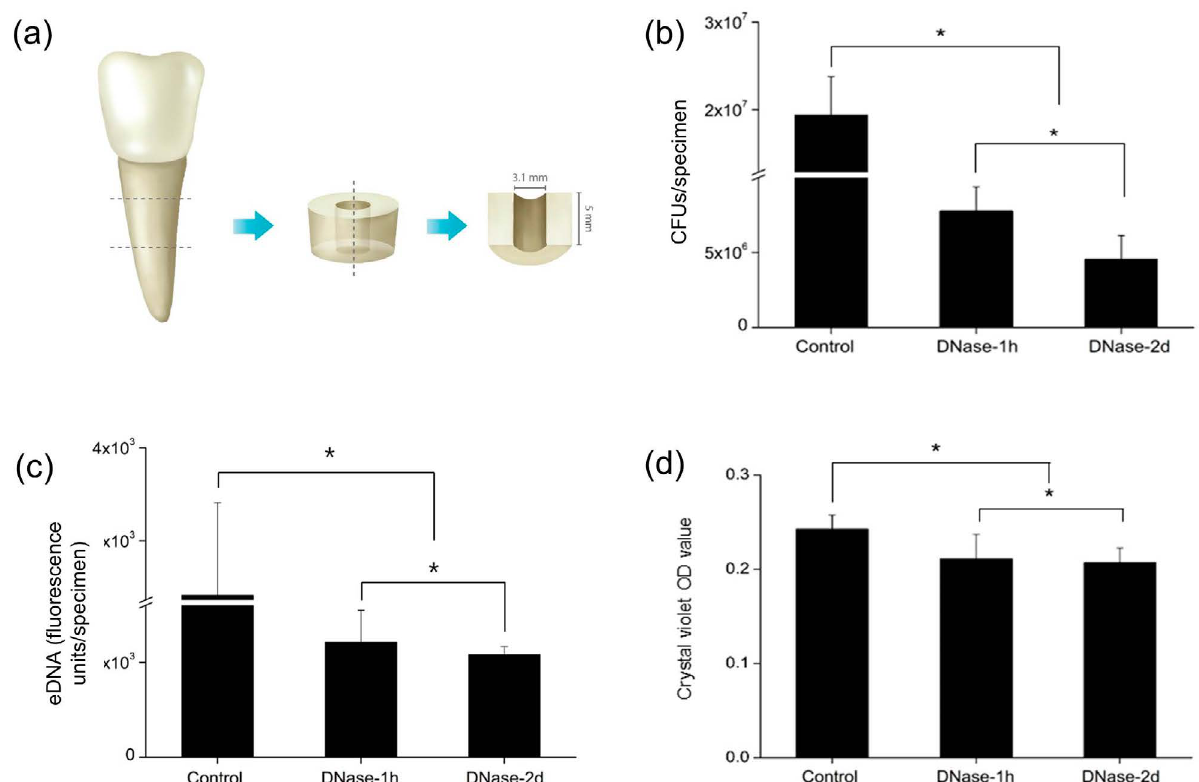
Figure 1- (a) Schematic illustration of the bovine root canal specimen. (b) CFUs of E. faecalis biofilms from the specimens. (c) eDNA measured using SYBR green. (d) Biofilm formation measured by crystal violet staining. Control: cultured only in BHI for 2 days, DNase- 1h: treated with DNase for 1 hour after 2-day culture in BHI, and DNase-2d: cultured with DNase for 2 days. *Statistical significance was determined at p<0.05